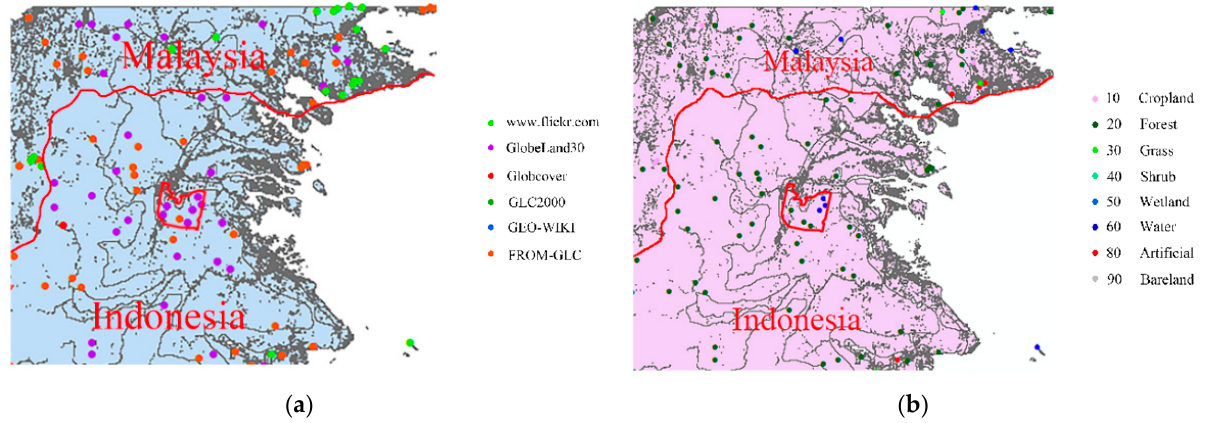
Figure 2. Verification points of the study area ( a ) Verification points according to the origin; ( b ) Verification points according to the classification of Globeland 30-2015.